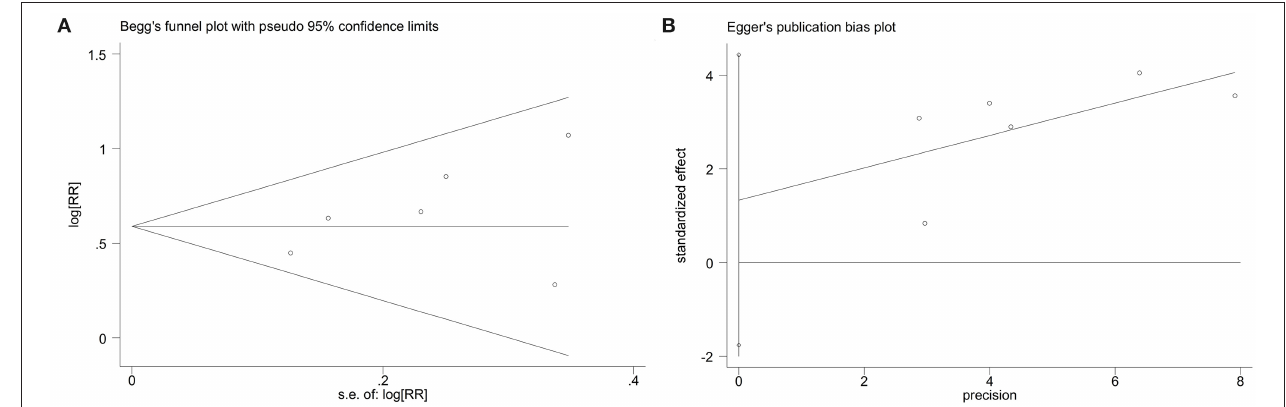
FIGURE 4 | Begg’s (A) and Egger’s (B) tests to detect publication